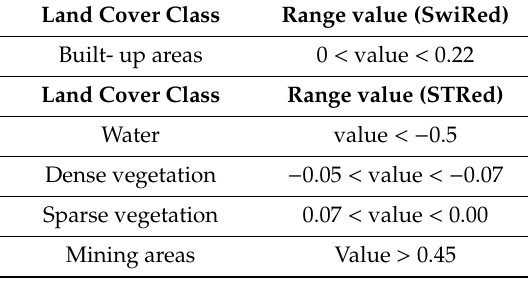
Table 2. Range value of LICA to extract the di ff erent land cover